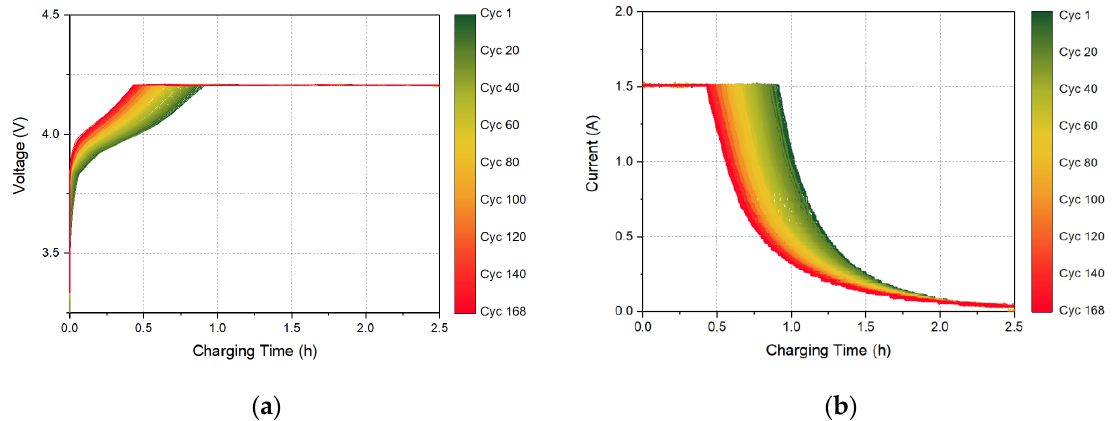
Figure 2. The variations of voltage and current of B05 in the CC-CV charging: ( a ) Charge voltage; ( b ) Charge current.